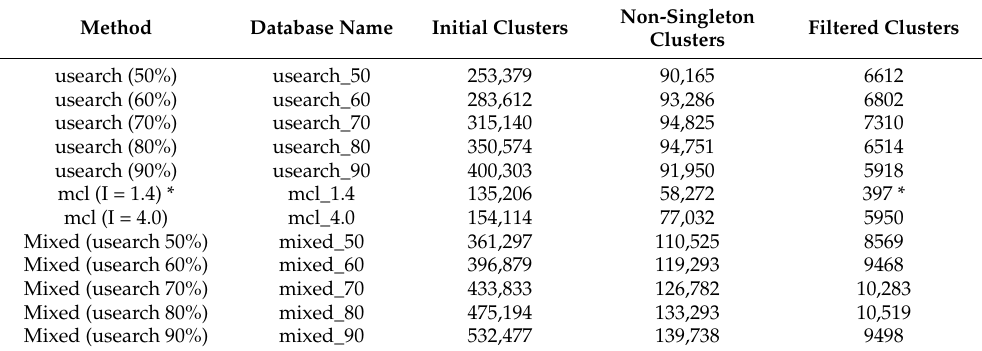
Table 3. Number of protein clusters yielded by each method following the removal of duplicate and polyprotein sequences. The final, filtered count of sequences was obtained by removing protein clusters whose membership did not sufficiently cover at least one viral subfamily (see methods for how coverage was assessed). Family and subfamily classifications were exported from the NCBI taxonomy record for each virus